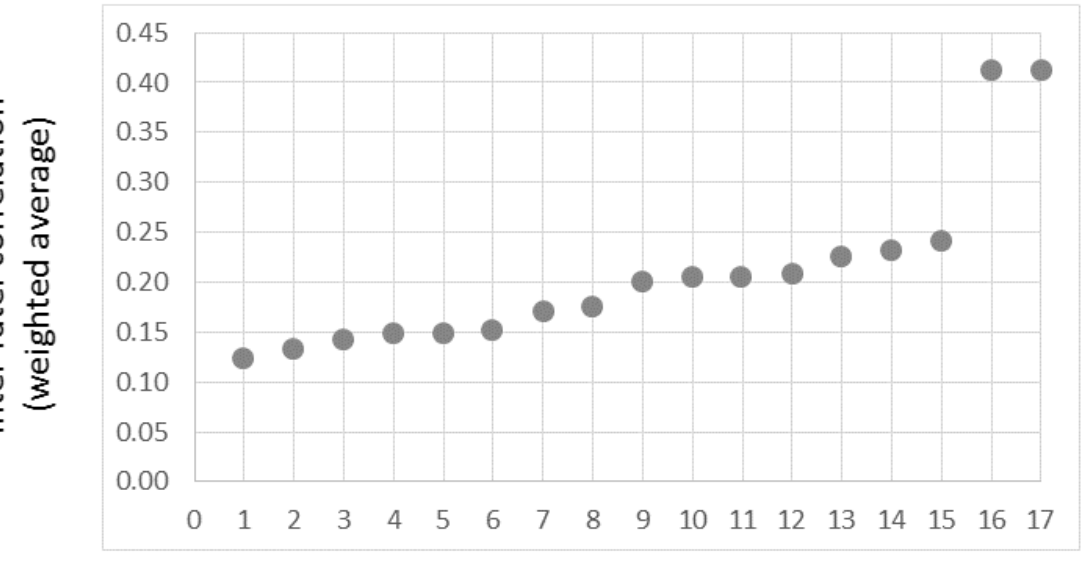
Figure 2. Inter-rater correlations (weighted average), with weakest three coders omitted. Note. N = 3499 codings, 17 coders. Y axis shows the mean Pearson correlation coefficients among coders’